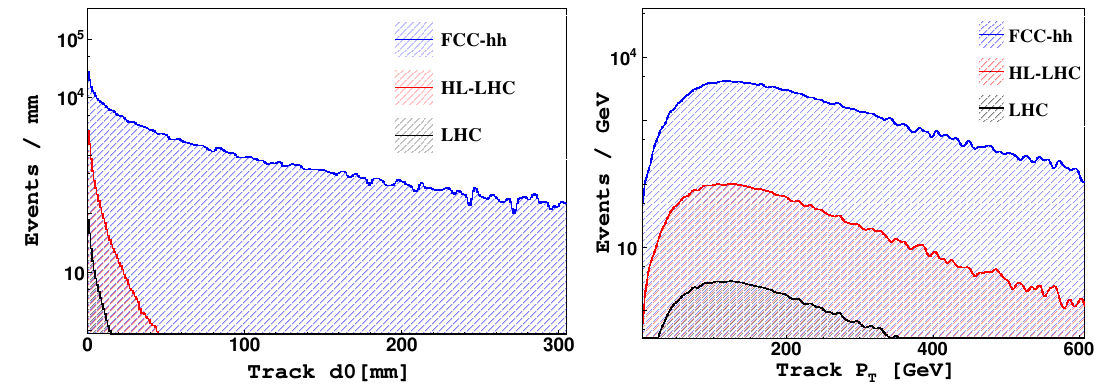
Figure 9 . Results from our simulations before applying any cuts. Left: impact parameter of the re- constructed track of H (cid:6)(cid:6) decaying to di-muons. Right: transverse momentum of the reconstructed track.